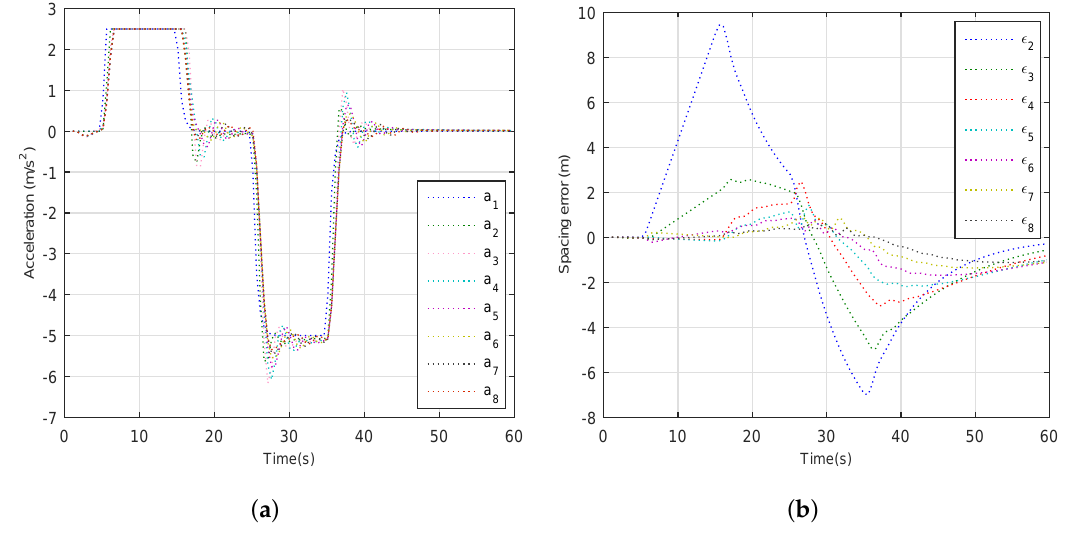
Figure 8. Vehicle dynamic characteristics: ( a ) acceleration; and ( b ) spacing